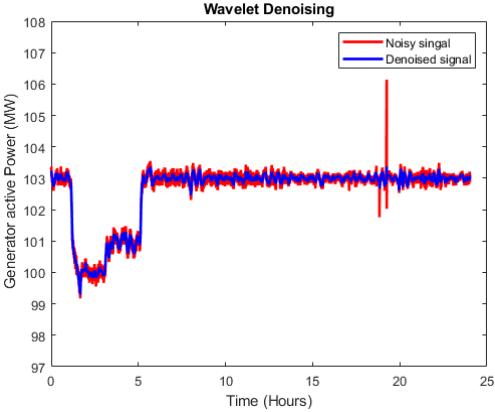
Figure 7. Denoising of the sensor data using the wavelet denoising method.